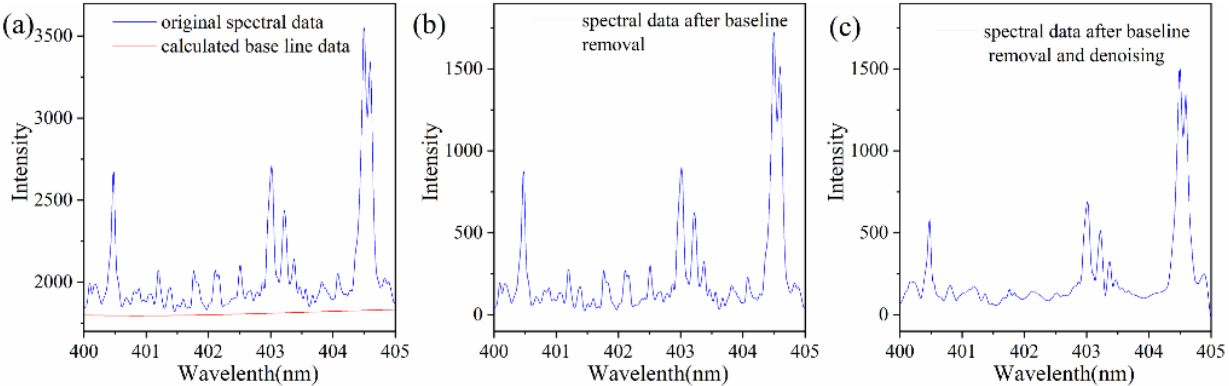
Figure 5. Enlarged view of the LIBS spectrum of sample GBW 01659a in the wavelength range of 400 – 405 nm: ( a ) the original spectral data (blue line) and calculated baseline data by cubic spline interpolation algorithm (red line); ( b ) the spectral data after baseline removal; ( c ) the data after denoising, obtained by subtracting the noise data from the data after baseline removal.